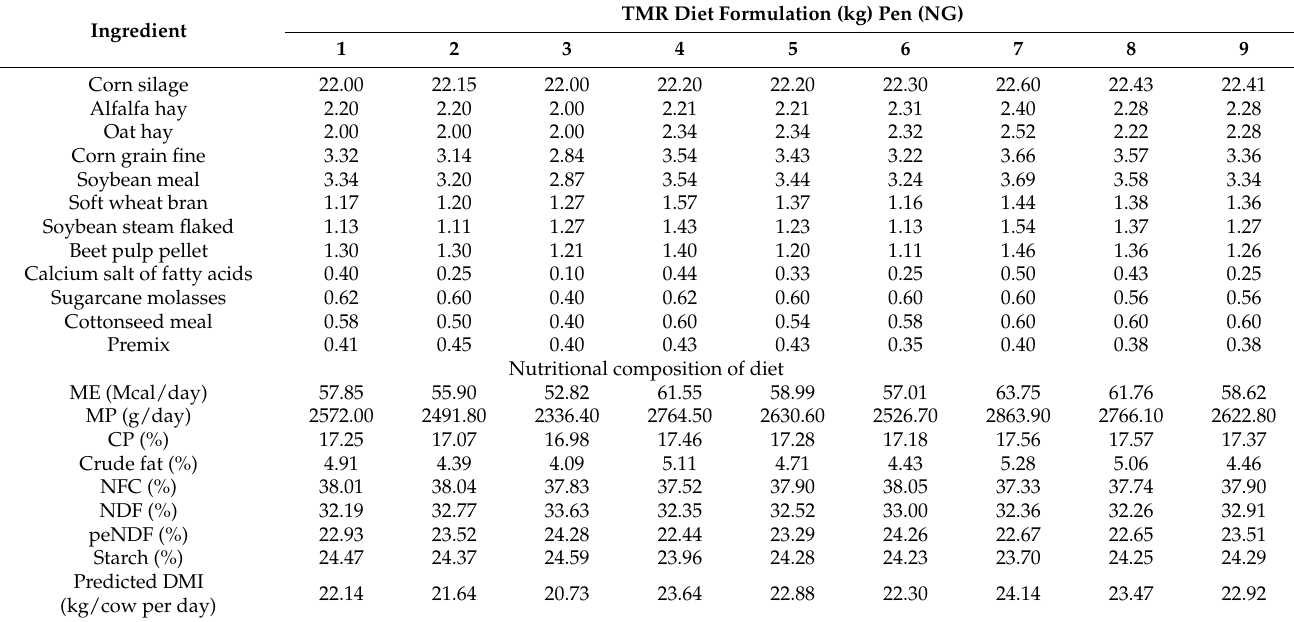
Table 2. Diet composition and routine nutrient composition—nutrient